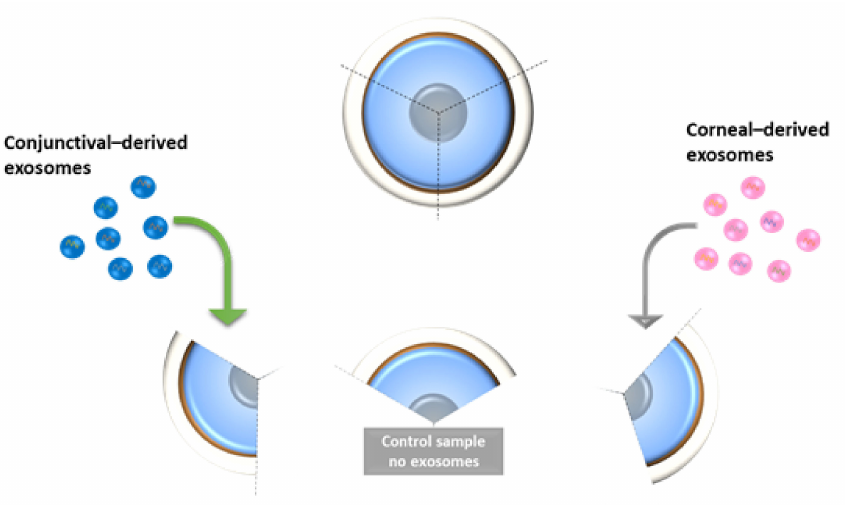
Figure 7. Illustration showing the methodology used for ex vivo study on human cadaveric donor corneal